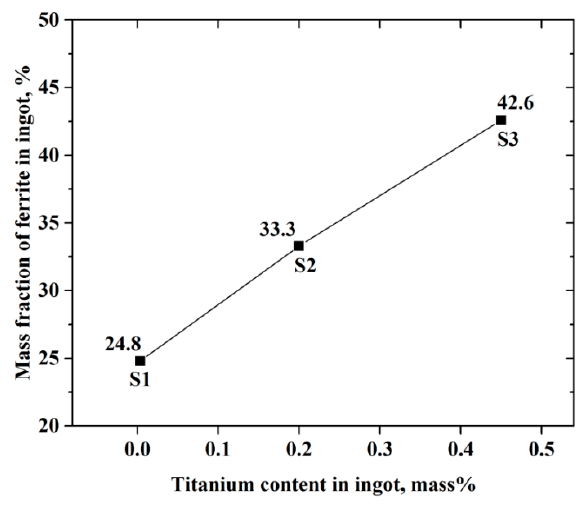
ff erent Ti content.